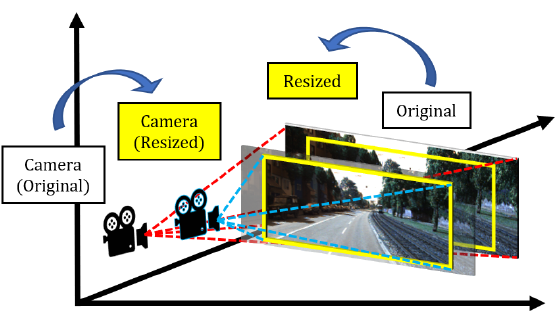
Figure 5. Image projected in 3D space with respect to the camera source. Resizing a region from the original image implies that the camera source moved forward along the Z